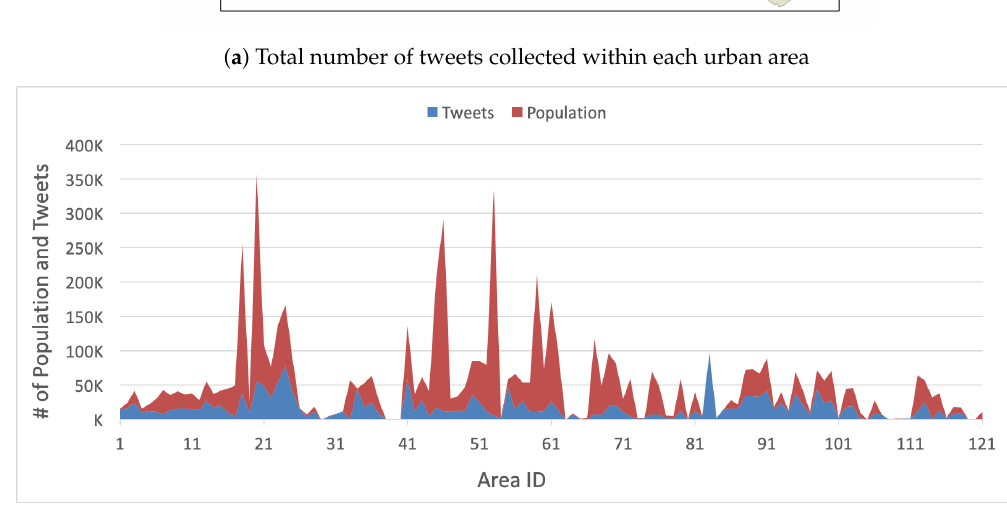
Figure 3. The distribution of data collected in the study